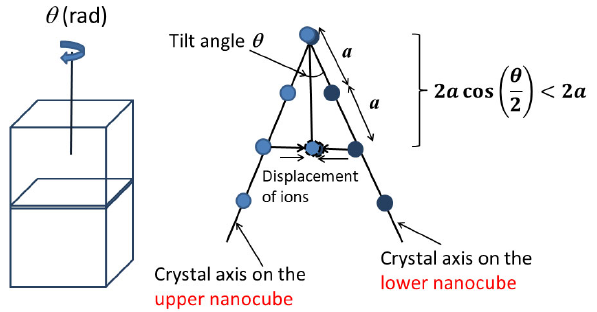
Figure 8. Misfit strain (the right figure) caused by a small tilt angle θ between two attached BaTiO 3 nanocubes (the left figure). The right figure is the projection view of the interface from the above. Two corresponding crystal axes on upper and lower nanocube are shown in the figure. The small circles are Ba ions. Reprinted with permission from Ref. [166]. Copyright 2020, IOP